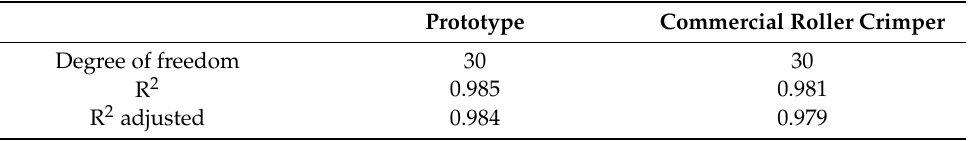
Table 2. Degrees of freedom, coefficient of determination, and coefficient of determination adjusted for the regressions carried out on the temporal trends of weed termination rate of the two machines in